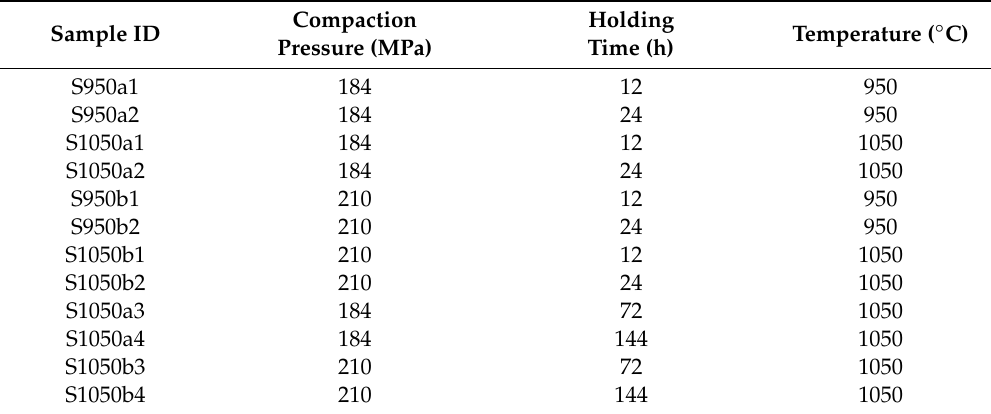
Table 2. Processing conditions of the alloy